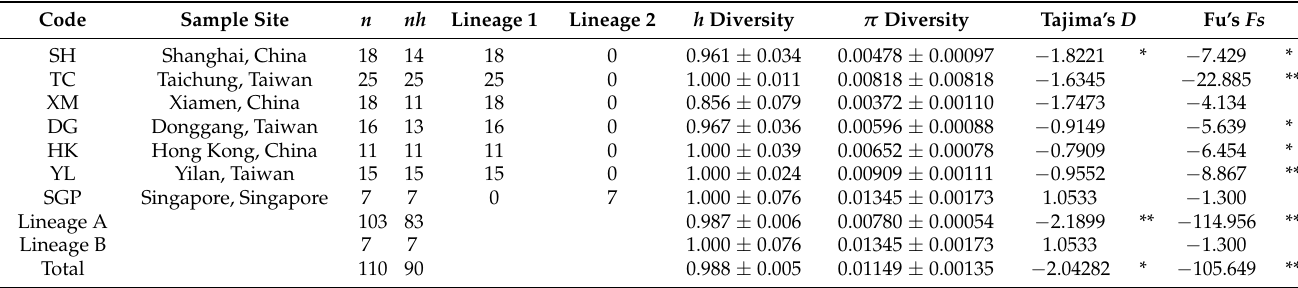
Table 1. Codes of sampling sites, sample sizes ( n ), number of haplotypes ( n h ), gene diversity ( h ), nucleotide diversity ( π ) and Tajima’s D and Fu’s Fs statistics for seven populations of Portunus sanguinolentus in East